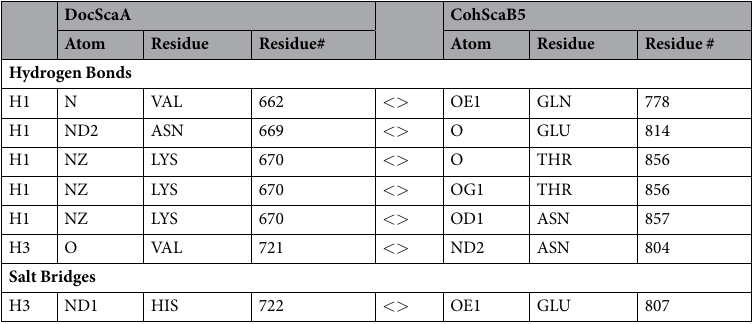
Table 2. Main polar contacts between Rf CohScaB5 and Rf DocScaA. The table was made using the PDBePISA server. Dockerin residues are marked as belonging either to helix 1 (H1) or to helix 3 (H3)